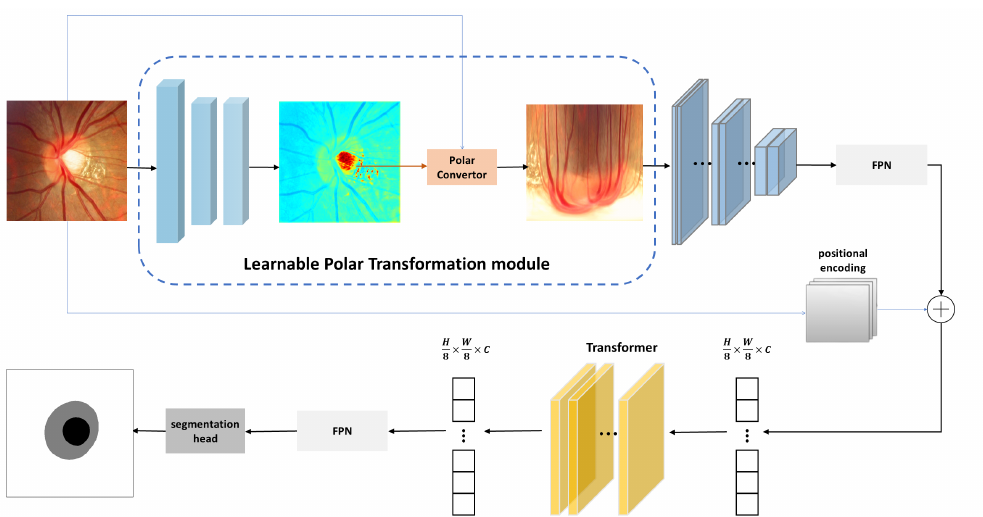
Figure 2. The architecture of our proposed